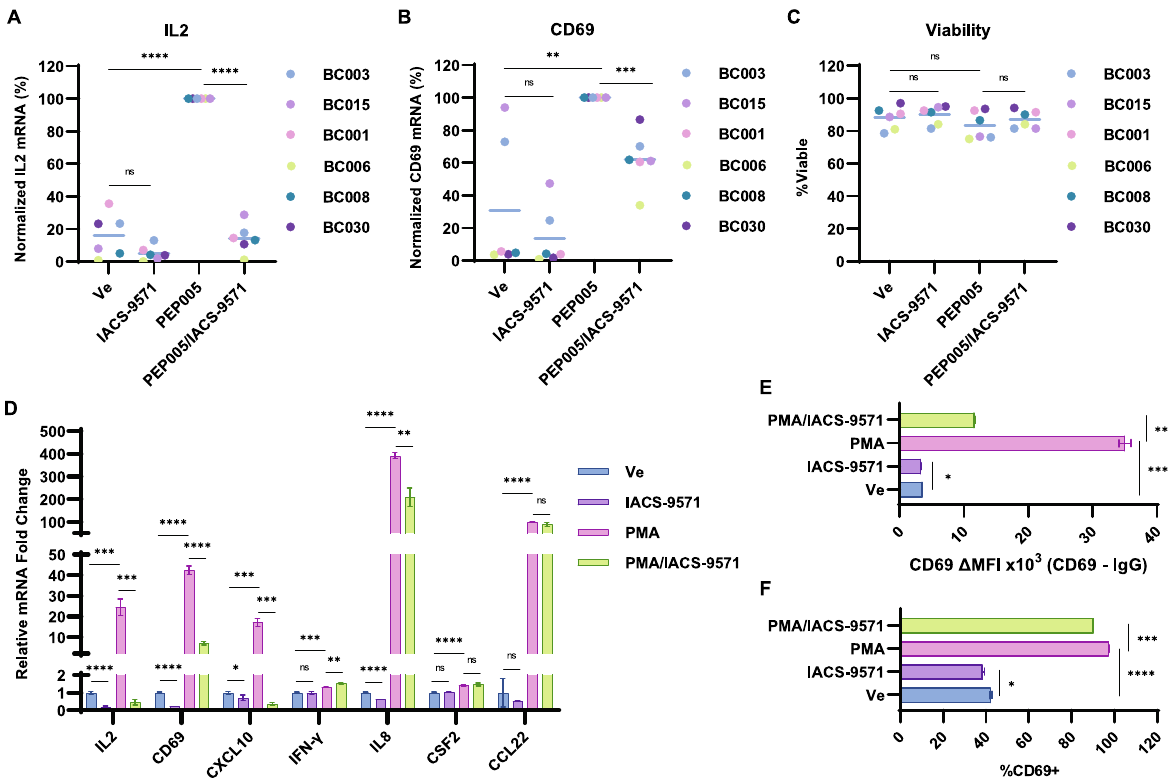
Figure 10. IACS-9571 inhibits a subset of T-cell activation response. ( A , B ) CD4 + cells from ART administered HIV-1 patients were treated with DMSO (Ve), 10 µM IACS-9571, 15 nM PEP005, or with 10 µM IACS-9571 and 15 nM PEP005 for 20 h. Following treatment, intracellular RNA was extracted and subject to RT-PCR using oligos that target IL2 (Panel A) or CD69 ( B ) mRNA. For each sample, RT-PCR was performed in replicate. ( C ) Viability of participant CD4 + PBMCs was assessed following treatment as in ( A , B ) using a Bio-Rad